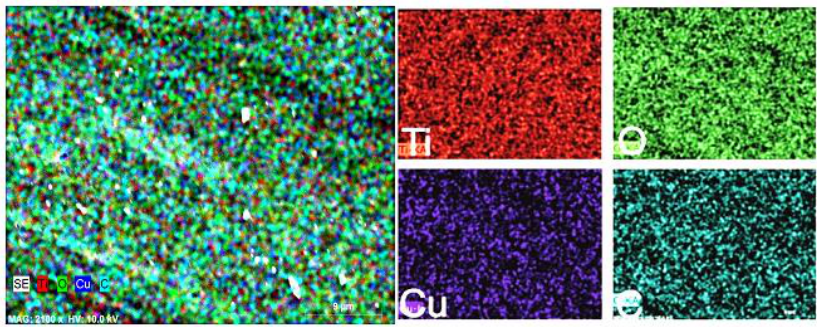
Figure 4. Cu (0.6 wt %) doped TiO 2 sample surface elemental analysis .